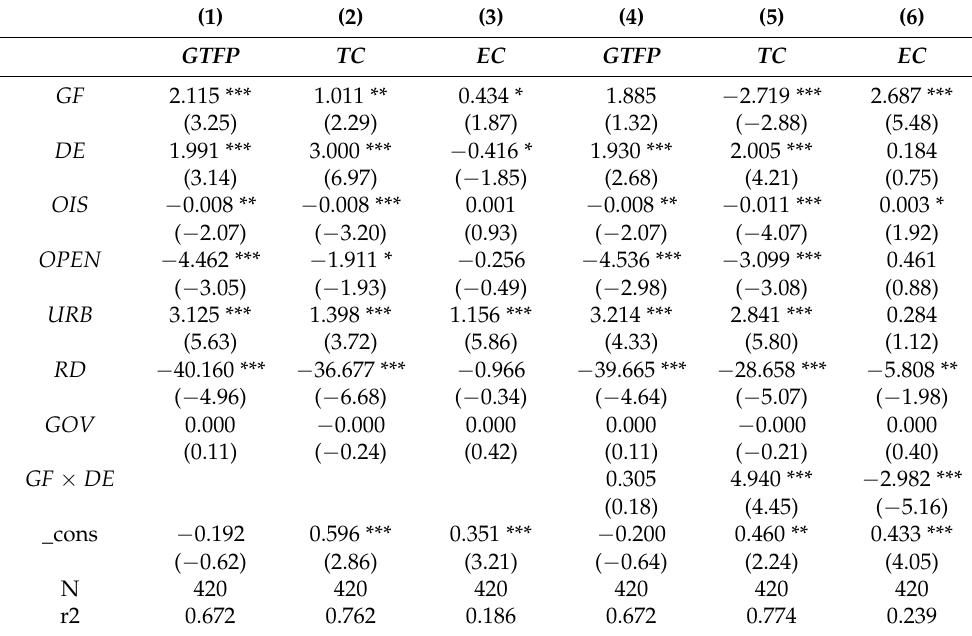
Table 6. Multiple regression